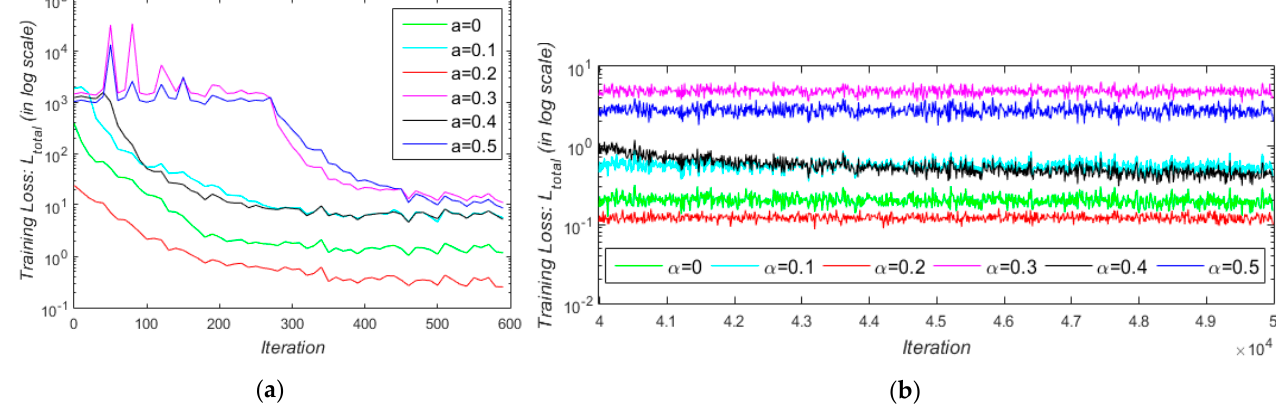
Figure 10. Loss curves for training TGL-Net-Mix by setting different values of loss trade-off parameter α , which is set from 0 to 0.5 with an increment of 0.1. For a better illustration, both vertical axes are shown in logarithmic scale. One iteration corresponds to training a batch of images with a batch size of 16. ( a ) Loss curve in iterations from 0 to 600; ( b ) loss curve in iterations from 4 × 10 4 to 5 × 10 4 . Table 11. Average values of non-reference measures on NTIRE datasets.